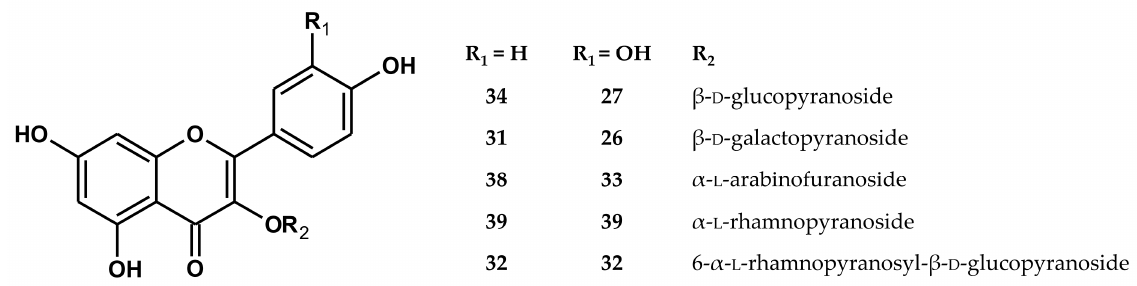
Figure 2. Structures of the main flavonoid glycosides identified in the extracts from the flowers of A. hippocastanum.